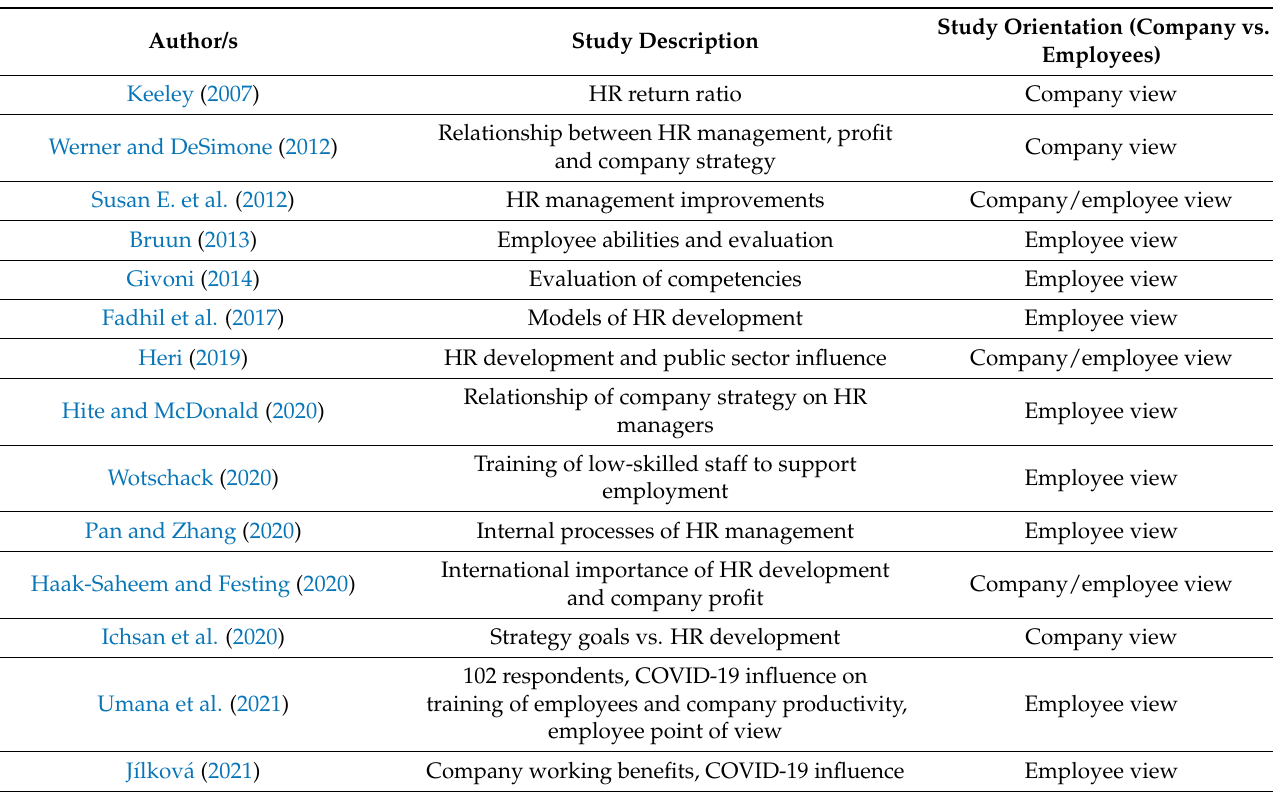
Table 1. A summary of previous